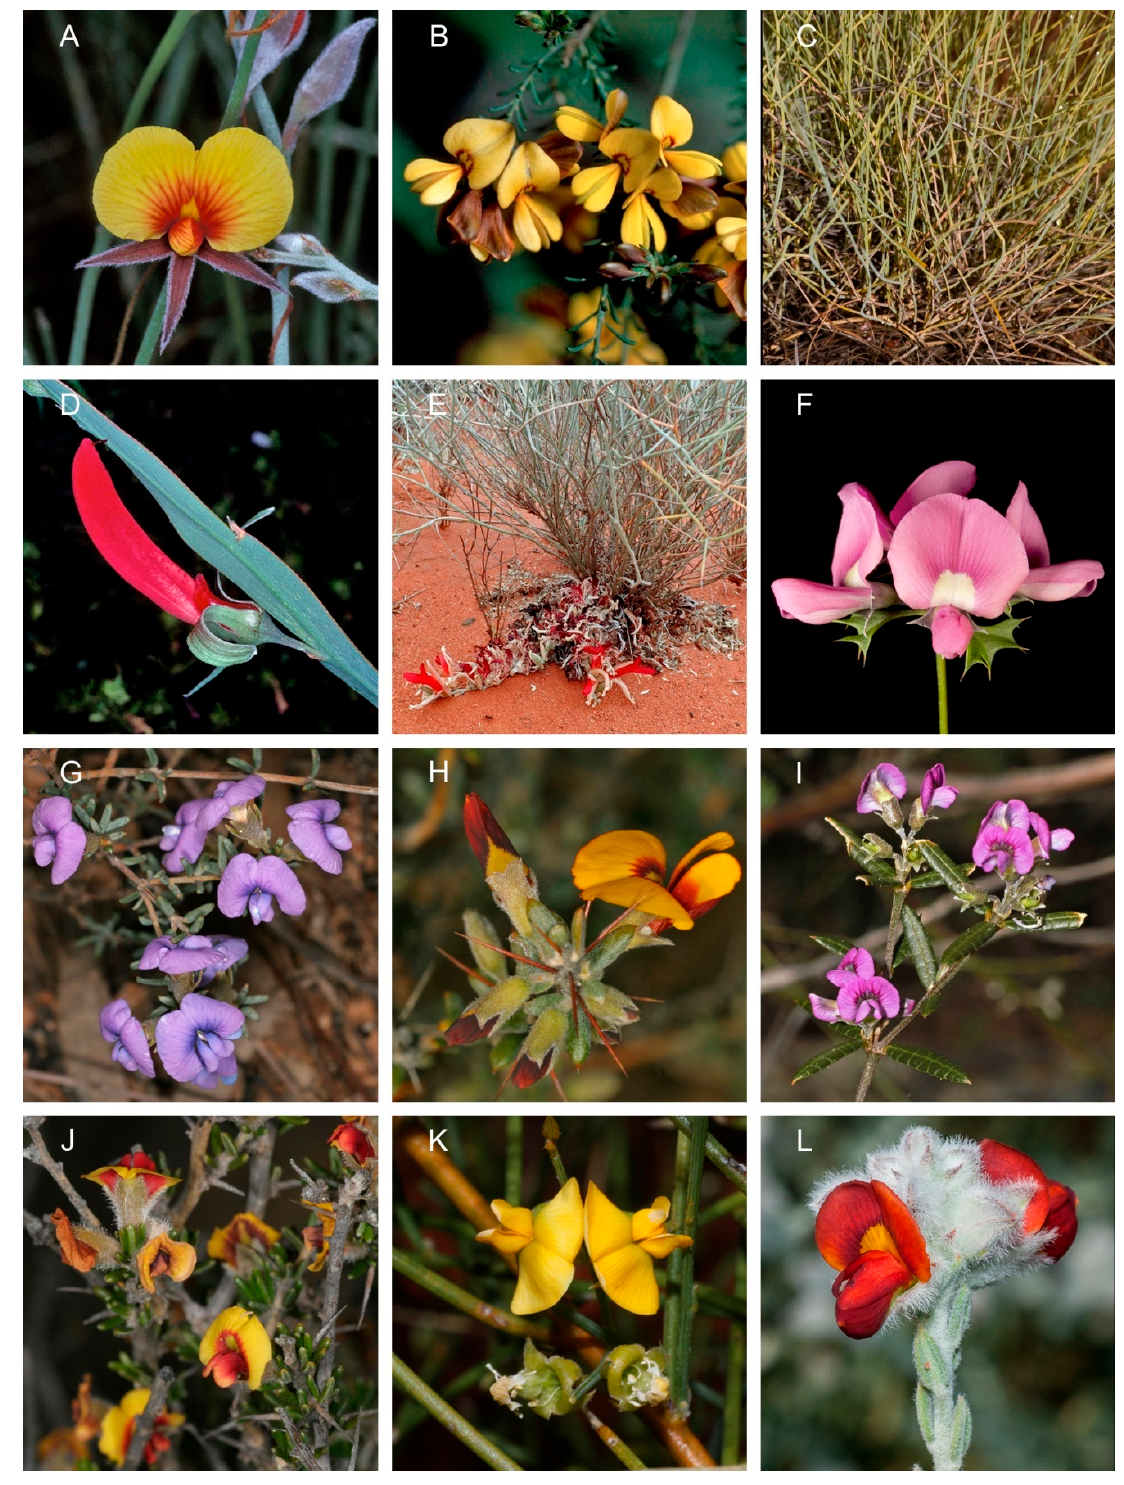
Figure 5. Morphological diversity of representative species from Fabaceae tribe Mirbelieae (core Mirbelieae). ( A ) Jacksonia restioides. ( B ) Latrobea glabrescens . ( C ) Leptosema anomalum . ( D ) Leptosema aphyllum . ( E ) Leptosema chambersii . ( F ) Mirbelia dilatata . ( G ) Mirbelia floribunda . ( H ) Mirbelia rhagodioides . ( I ) Mirbelia rubiifolia . ( J ) Mirbelia trichocalyx . ( K ) Mirbelia viminalis . ( L ) ‘Otion’ simplicifolium . Photographs by Russell Barrett except ( A ) by Michael Crisp, ( D , E ) by Murray Fagg and ( F ) by Kevin Thiele ( D – F ) from the Australian Plant Image Index: http://www.anbg.gov.au/photo (accessed on 11 June 2021)).